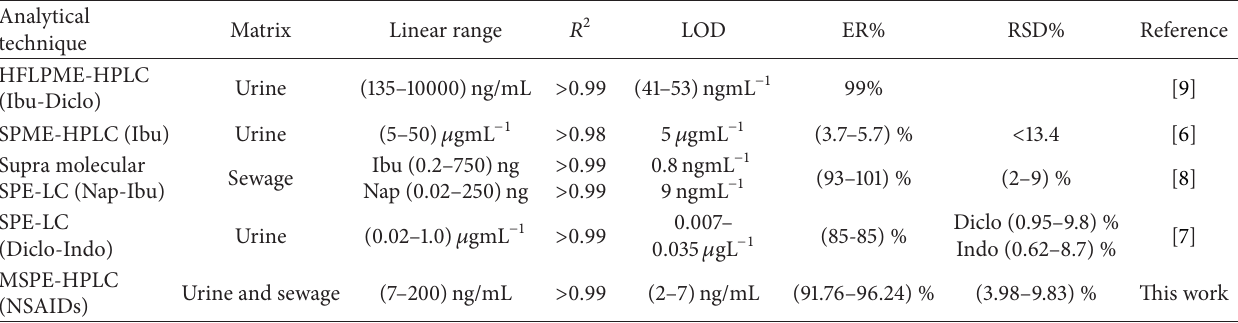
Table 4: Comparison of the proposed method with other analytical methods for the determination of different nonsteroidal anti- inflammatory drugs in various samples.